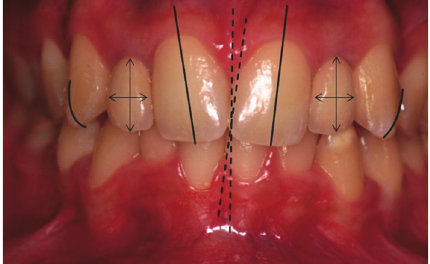
Figure 2: Frontal view showing the mid sagittal line alteration between the midline of the maxillary and mandibular arches (dotted lines); changes in the long axis of the maxillary central incisors (unbroken lines); disharmony in the height-width ratio of the lateral incisor crowns (crossed arrows); more prominent incisal thirds of the maxillary canines projected in the labial direction with sharp appearance (schematic drawing with curved lines pointing out the sharp aspect of canines).